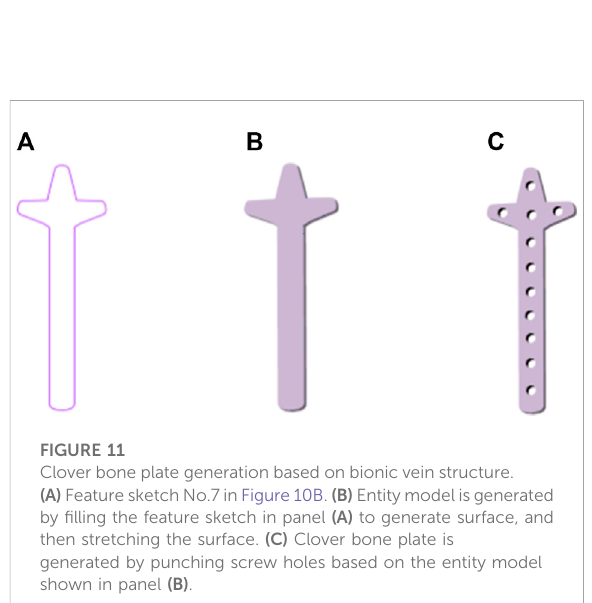
FIGURE 12 Entity meshing model of clover bone plate. (A) The clover bone plate after meshing. In grid division, the absolute sag was set to2mm,andmeshsizewassetto10mm. (B) Nodesandelements of grid division. The aspect ratio was 97.58% and the streth 100%, showing the meshing result is